Question: Produce a descriptive caption suitable for publication.
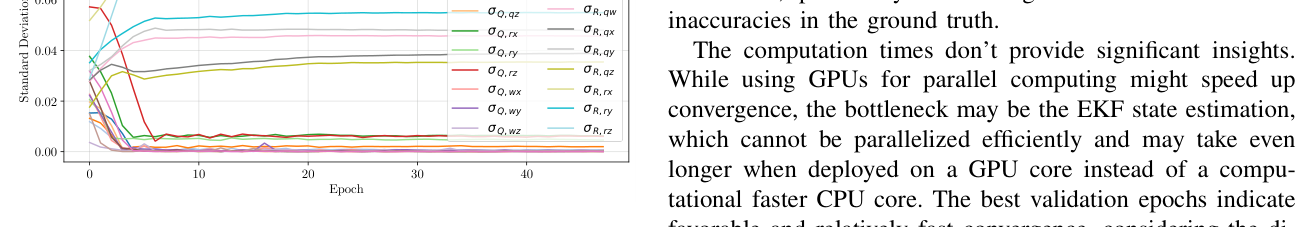
Answer: Convergence behavior of the learned parameters during training with DS2. The 20 noise covariance terms that the DFCNN is learning from the DS2 are tracked over each epoch and depicted in this graph.